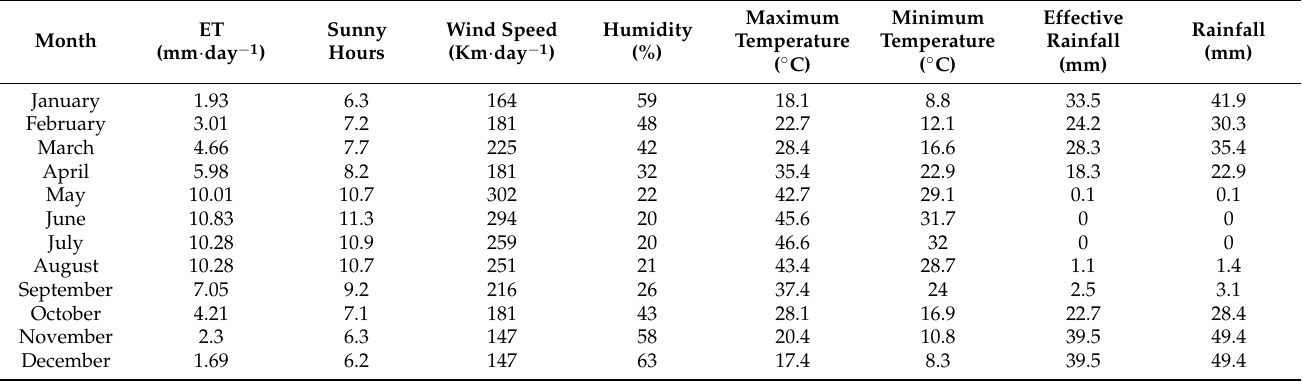
Table 3. Climatic characteristics over a 20-year statistical period (1999–2019) in